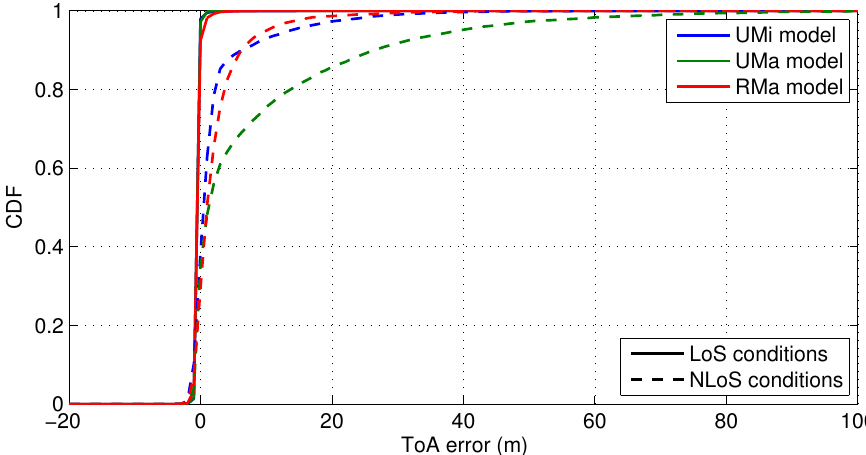
Figure 6. CDF of the ranging errors with a cmWave signal of 90-MHz bandwidth for WINNER channel models in LoS and NLoS